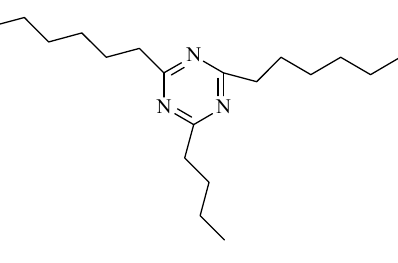
Figure 15. The structure of triazine.